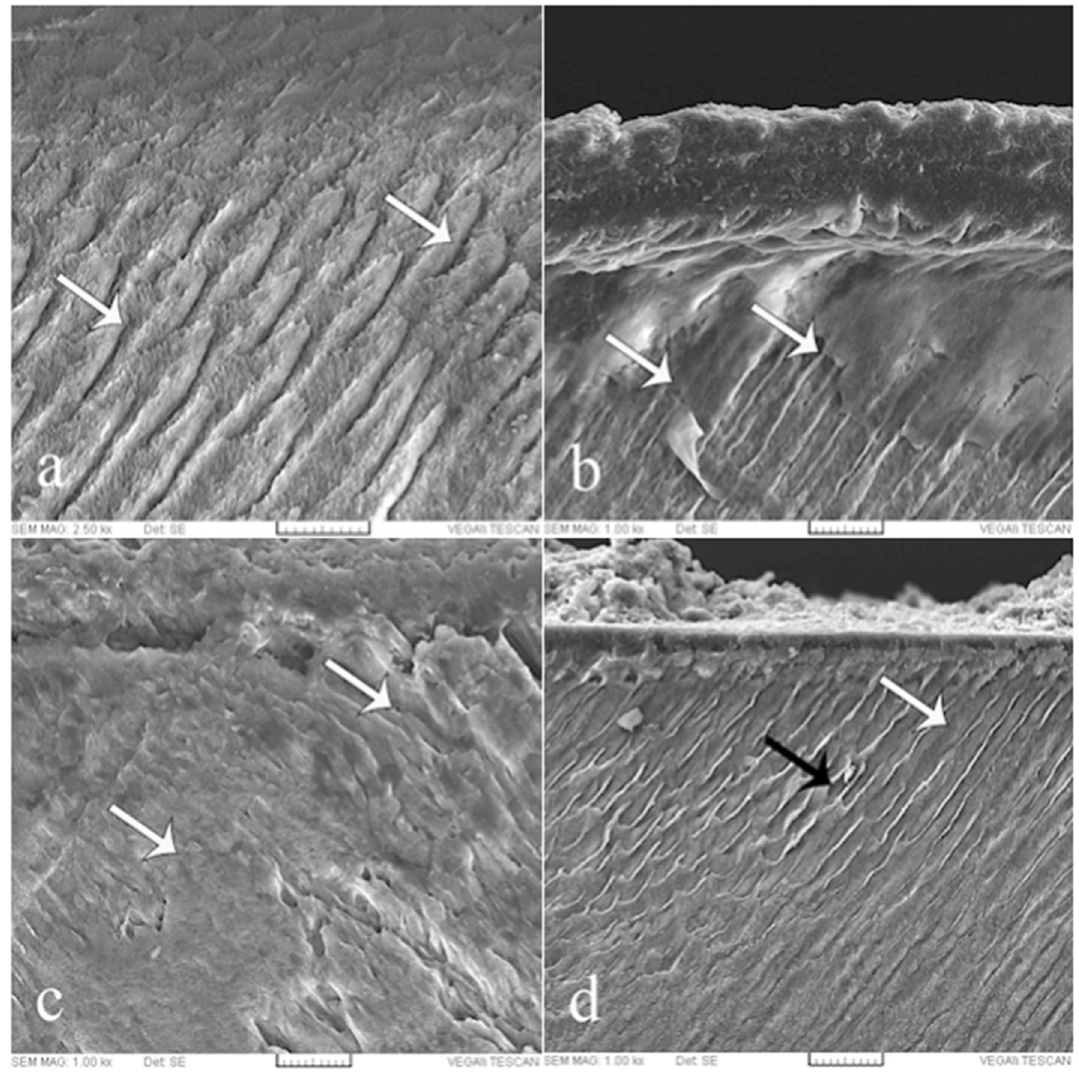
1) (arrows), ( c ) Infiltrant resin penetrated into deeper areas and disperses across a larger area (arrows) (group 3), ( d ) Fissure sealant penetration and interface with the enamel treated with 15% hydrochloric acid (group 4). White arrow shows infiltrated area and black arrow shows non-infiltrated area. Magnification: 2500 × and 1000